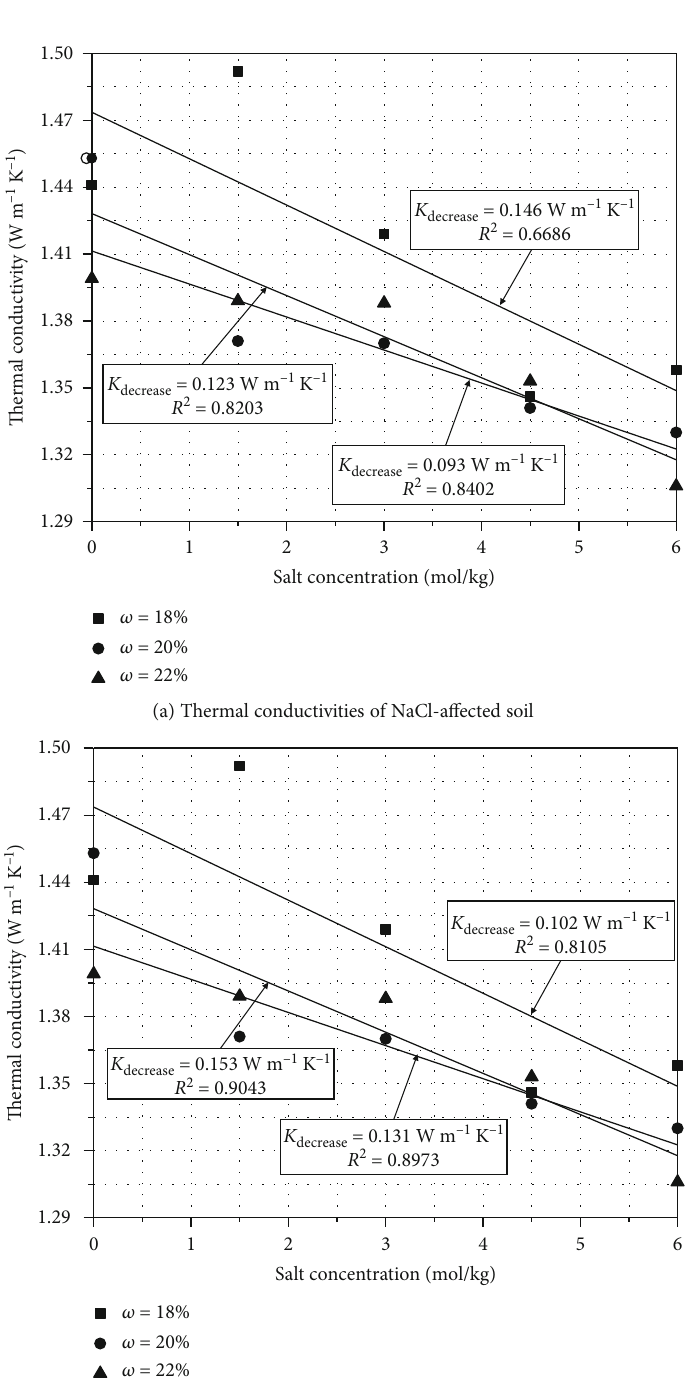
Figure 11: Thermal conductivities of saline soil ( K 0mol/kg to